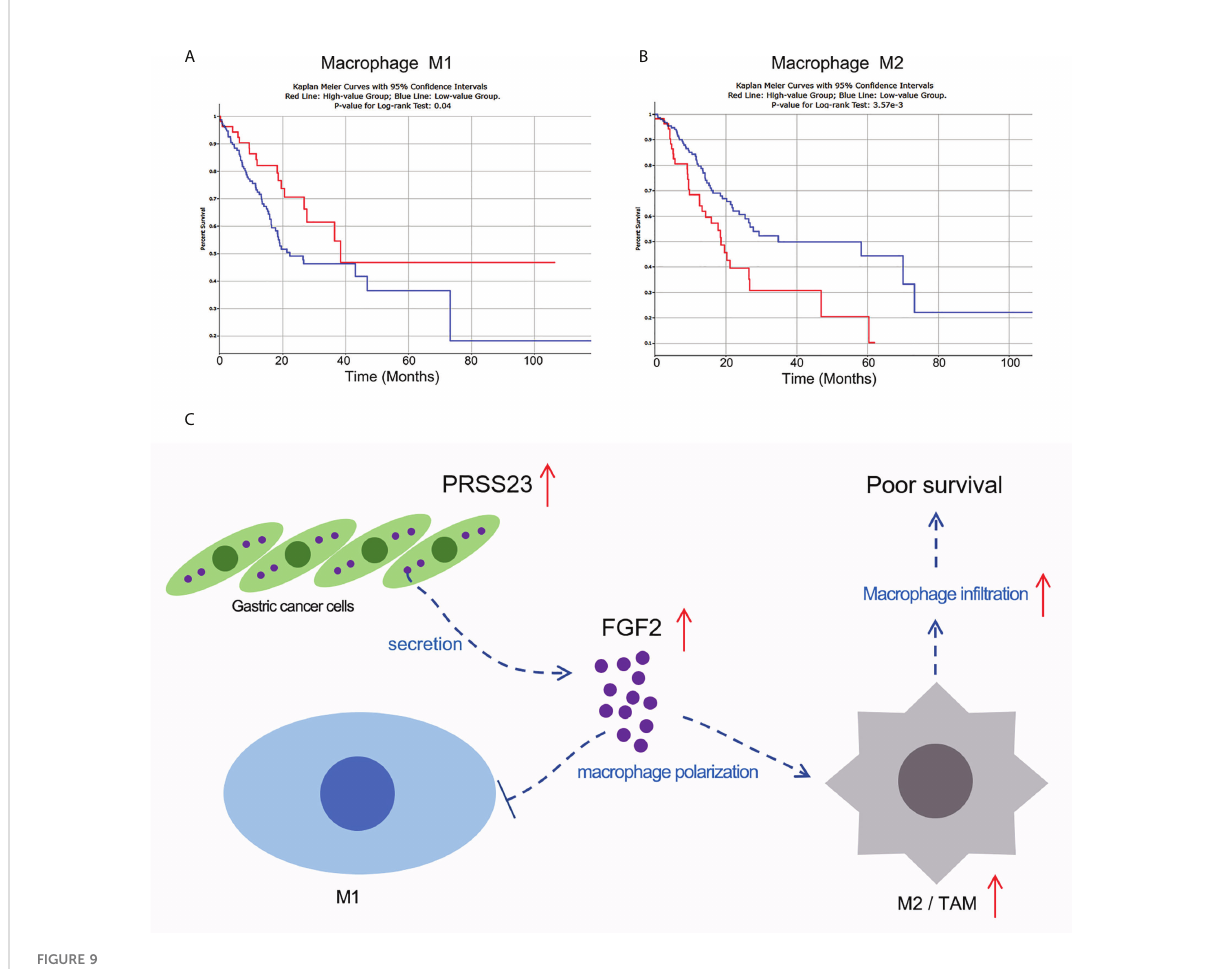
FIGURE 9 Working model of PRSS23/FGF2 axis in regulating macrophage in fi ltration. (A) High level of M1 macrophage in fi ltration predicted favorable prognosis in GC. (B) High level of M2 macrophage in fi ltration predicted poor prognosis in GC. (C) Working model of PRSS23/FGF2 axis in macrophage in fi ltration. PRSS23 was overexpressed in GC, which enhanced the expression and secretion of FGF2. Meanwhile, FGF2 upregulation drives macrophage polarized towards M2/TAM phenotype, thereby resulting poor prognosis in GC. Taken together, PRSS23 promotes TAM/M2 macrophage in fi ltration through positively regulating FGF2 expression and